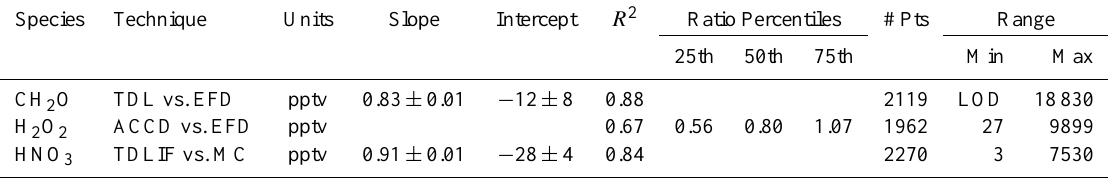
Table 4b. DC-8 intra-platform comparison. Photochemical products. NOTE: Technique is listed as X vs. Y. Species